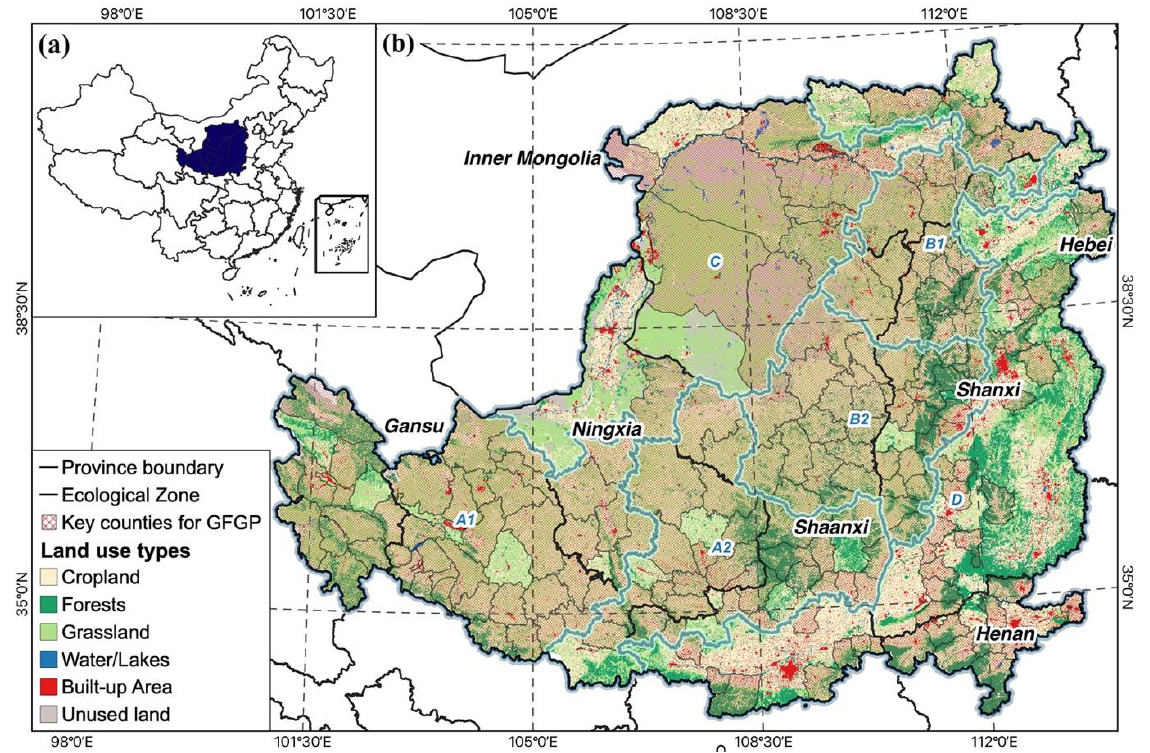
Figure 1. The land use map of the study area ( a ) and its location in China ( b ). Note: loess sorghum gully region A1; loess sorghum gully region A2; loess hilly and gully region B1; loess hilly and gully region B2; sandy land and agricultural irrigation region C; earth-rocky mountainous, and river valley plain region D. The key counties data were offered by the local government.